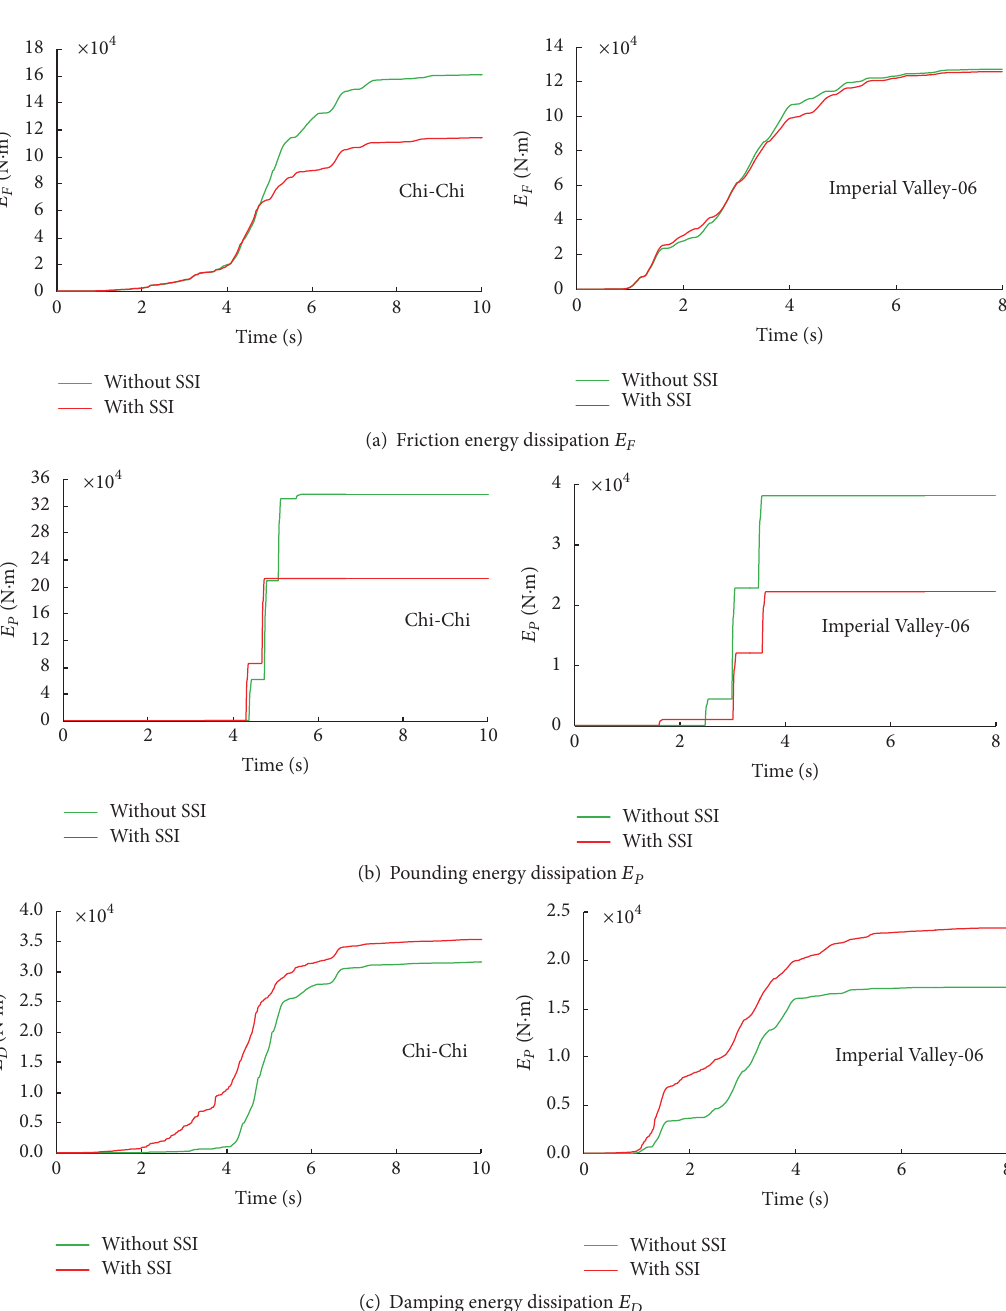
Figure 7: Effects of SSI on energy